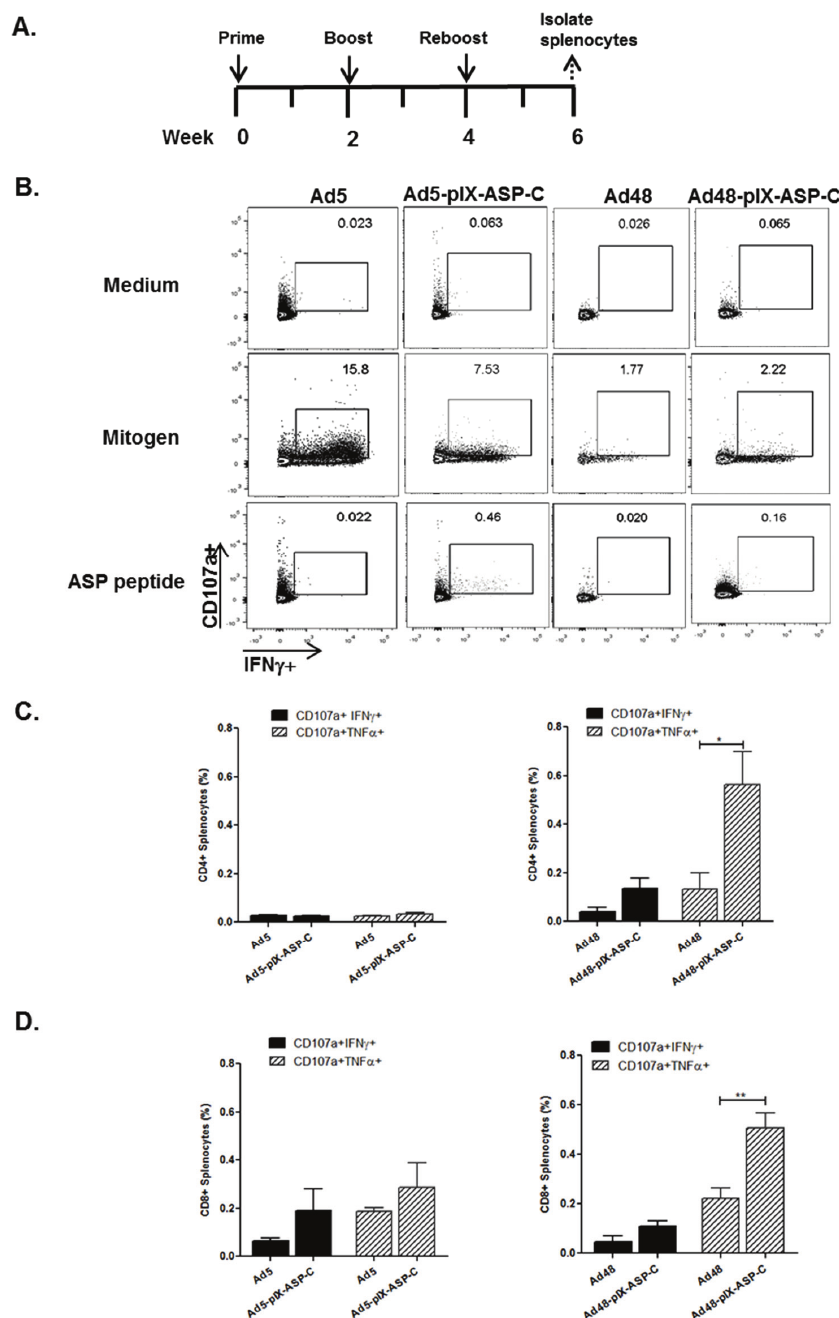
Figure 5. Frequencies of double positive phenotypes of T. cruzi- specific T-cell responses mice immunized with pIX-modified vectors. ( A ) Study design: C57BL/6 mice were immunized intramuscularly with Ad5, Ad5-pIX-ASP-C, Ad48, or Ad48-pIX-ASP-C at the indicated time points.